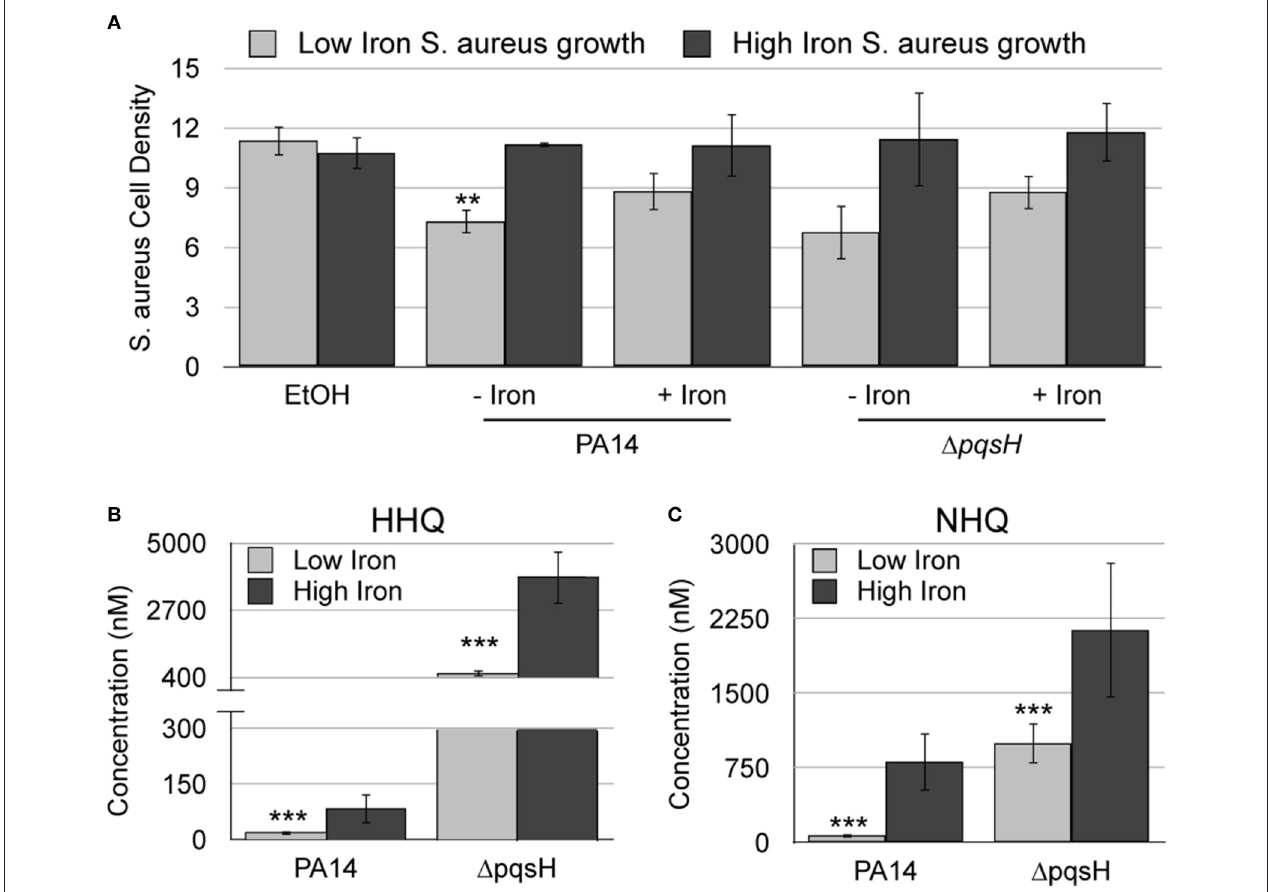
FIGURE 4 | HHQ is overproduced by the 1 pqsH mutant. (A) S. aureus was grown overnight in DTSB supplemented with or without 100 µ M FeCl 3 and the indicated P. aeruginosa AQ extracts. OD 600 of overnight S. aureus cultures was measured as described in Section Materials and Methods. (B,C) Culture supernatant extracts from the indicated P. aeruginosa strains, grown with or without 100 µ M FeCl 3 were analyzed by LC-MS/MS as described in the Section Materials and Methods. Error bars indicate standard deviation of three (A) and five (B) biological replicates. Asterisks (*) indicate the following p -values as determined by two-tailed Student’s t -test: ** p < 0.005, *** p < 0.0005 when comparing low iron to high